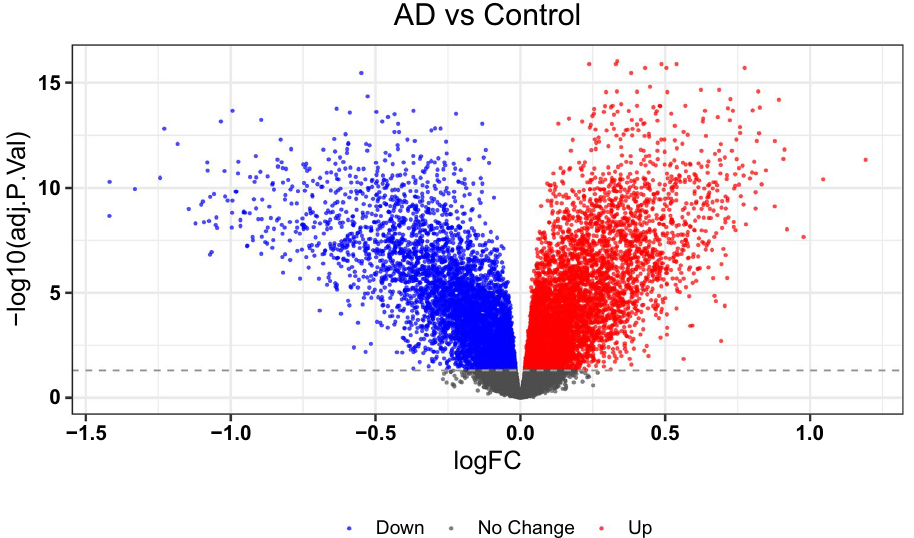
Figure 1. Volcano plot of differential gene expression between AD patients and matched controls from the GEO